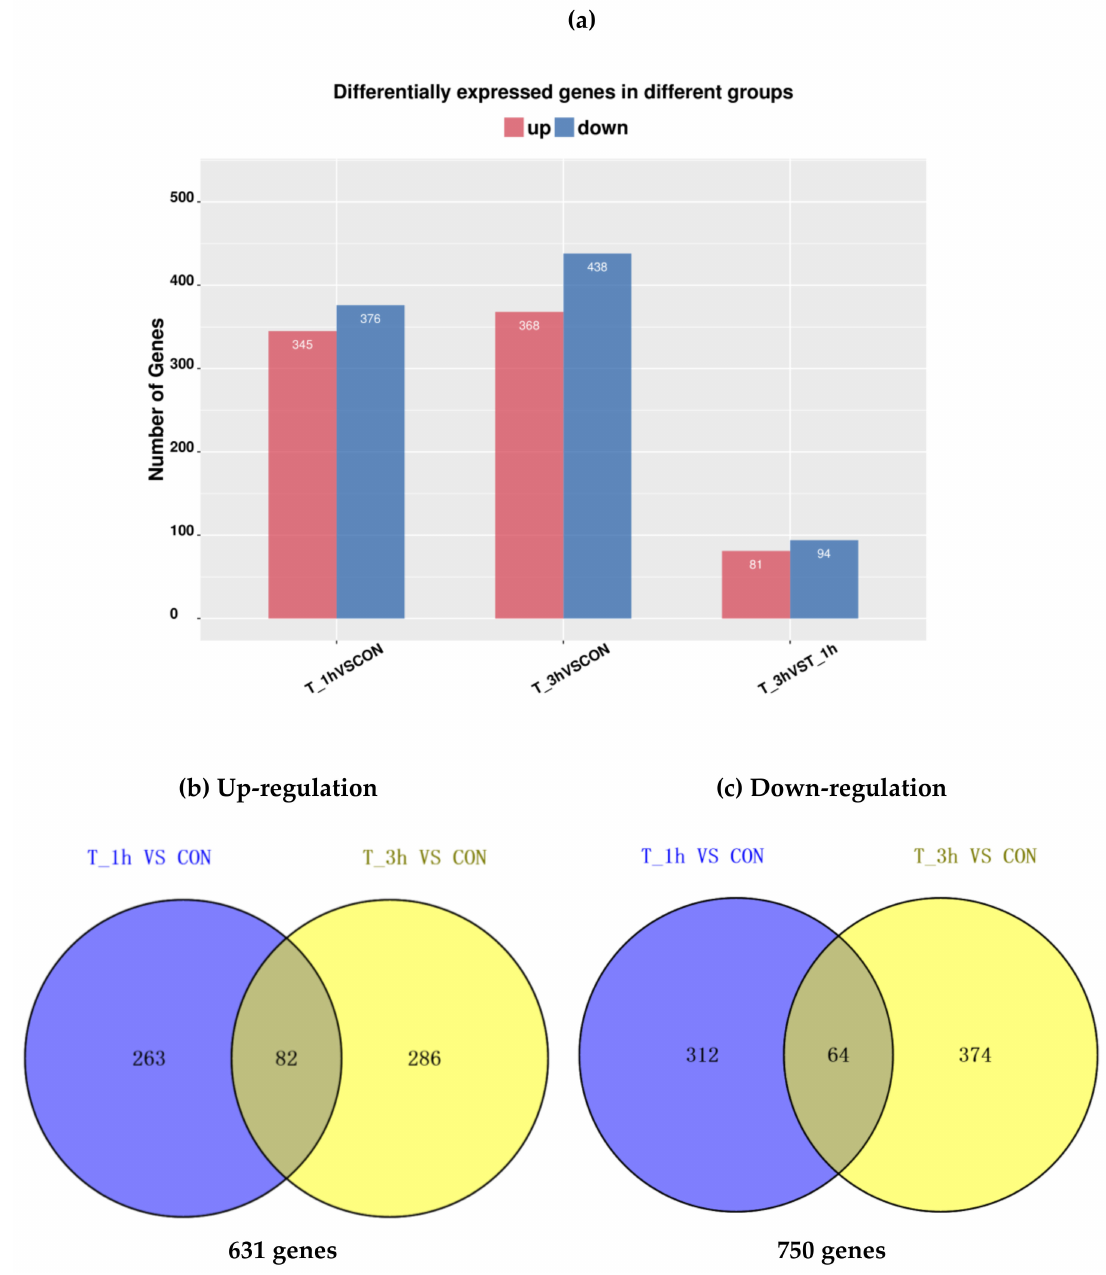
Figure 1. ( a ) The differentially-expressed genes (DEGs) of AJBW during tenderization. ( b ) Upregulated genes of T_1h and T_3h compared to CON. ( c ) Downregulated genes of T_1h and T_3h compared to